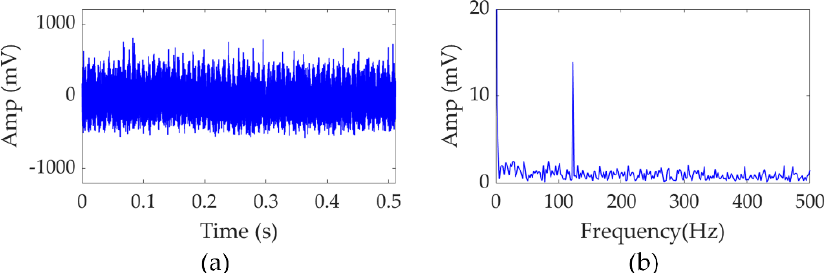
Figure 7. ( a ) The denoised signal waveform by SRSVD and ( b ) its frequency spectrum.